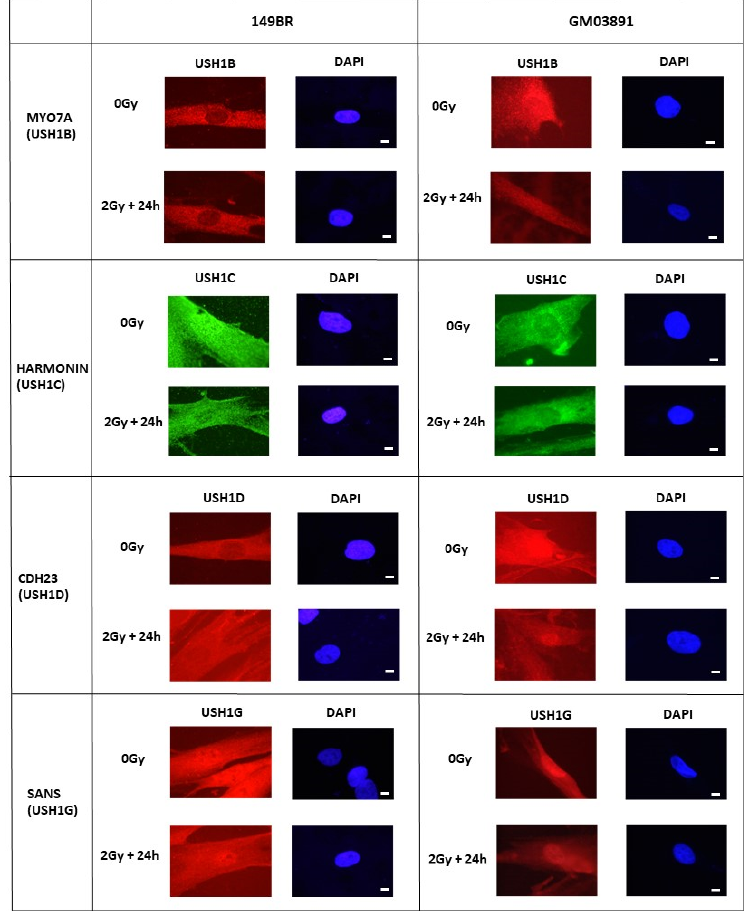
Figure 6. Subcellular localization of USH1 proteins in USH1 and control fibroblasts: Anti-USH1B/MYO7A, anti-USH1D/CDH23, anti-USH1C/Harmonin, and anti-USH1G/SANS immunofluorescence was applied to the radioresistant 149BR controls and the USH1 GM03891 fibroblasts, either before or after irradiation (2 Gy + 24 h), as indicated. The white bar represents 5 µm.